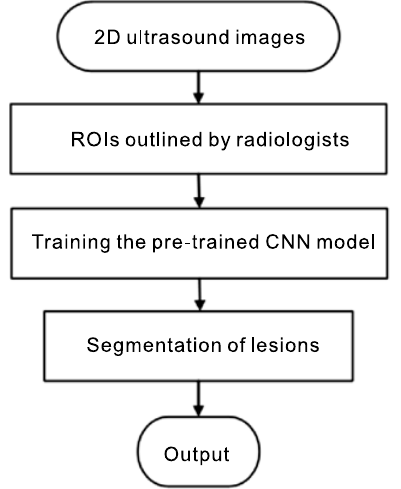
Figure 1 Flowchart of the proposed convolutional neural network model for ultrasound image segmentation. Here, 2D denotes 2 dimensional, ROIs denotes regions of interest, CNN denotes convolutional neural